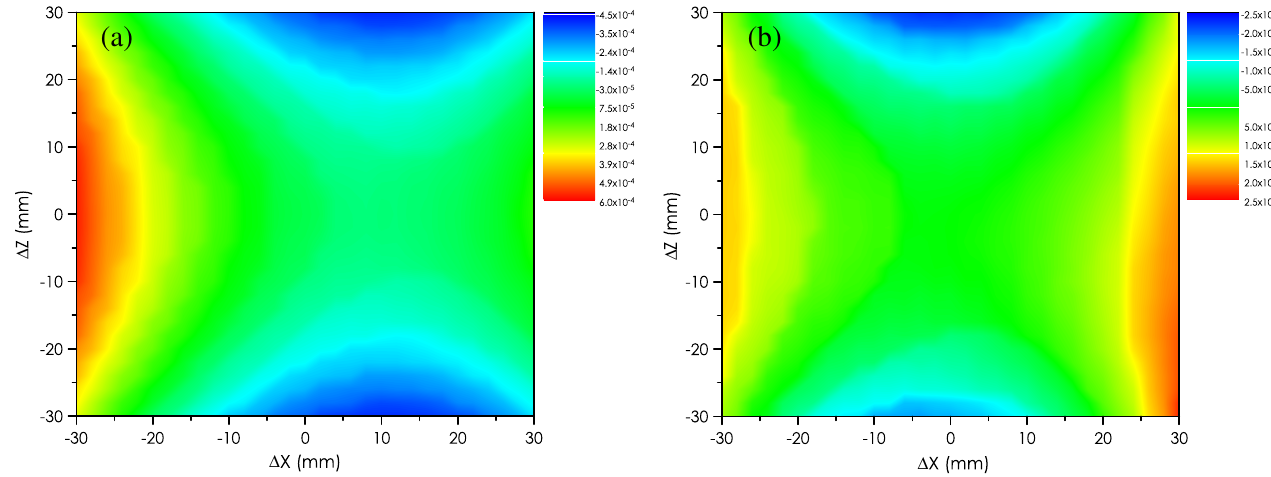
FIG. 9. Uniformity of the BL products, (cid:1) B z L=B z L , of the dipole field for the small-aperture magnet (a) before and (b) after